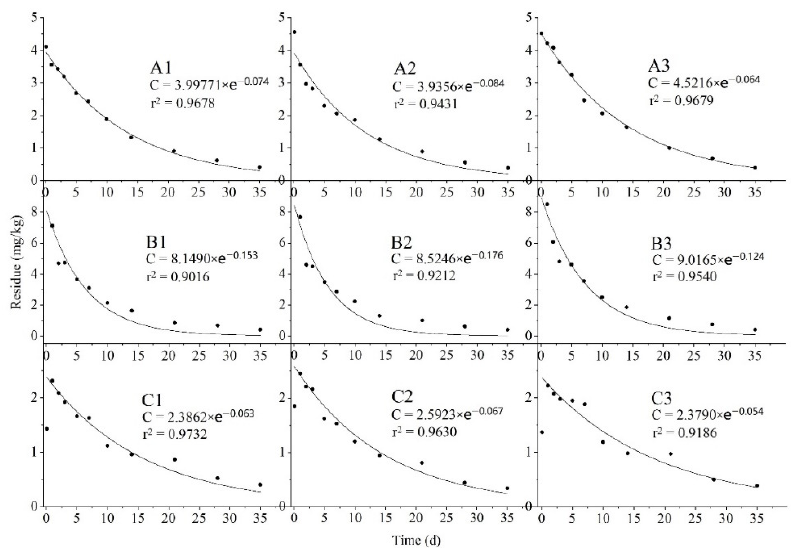
Figure 3. Dissipation equation of prochloraz residues in whole banana samples in Guangdong ( A1 ), Hainan ( A2 ), and Yunnan ( A3 ); dissipation equation of prochloraz residues in banana peel samples in Guangdong ( B1 ), Hainan ( B2 ), and Yunnan ( B3 ); dissipation equation of prochloraz residues in banana pulp samples in Guangdong ( C1 ), Hainan ( C2 ), and Yunnan ( C3 ).